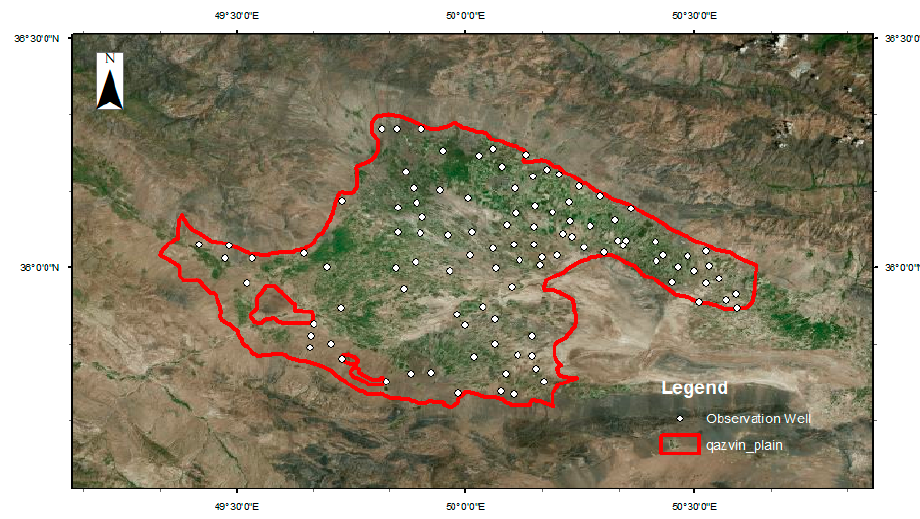
Figure 2. Location of the selected observation wells.